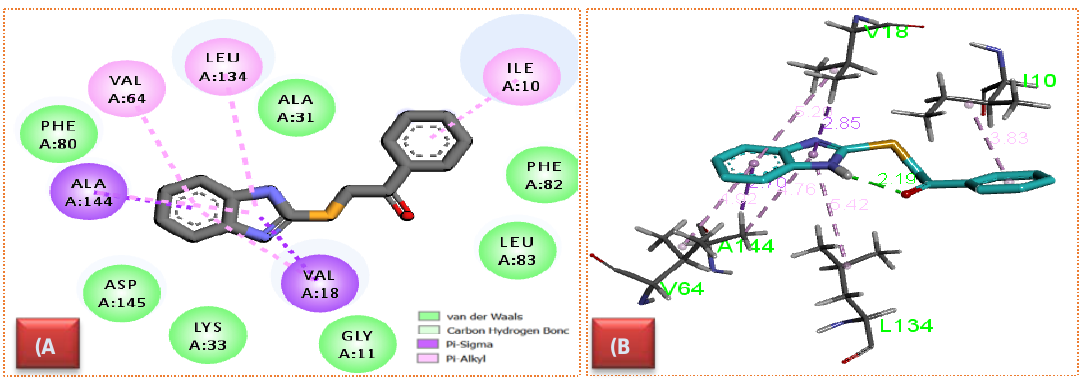
Figure 5. ( A ) 2D and ( B ) 3D diagram of benzimidazole 10d displaying its interaction within CDK2 Figure 5. (A) 2D and (B) 3D diagram of benzimidazole 10d displaying its interaction within CDK2 kinase active site (distances in kinase active site (distances in Å).